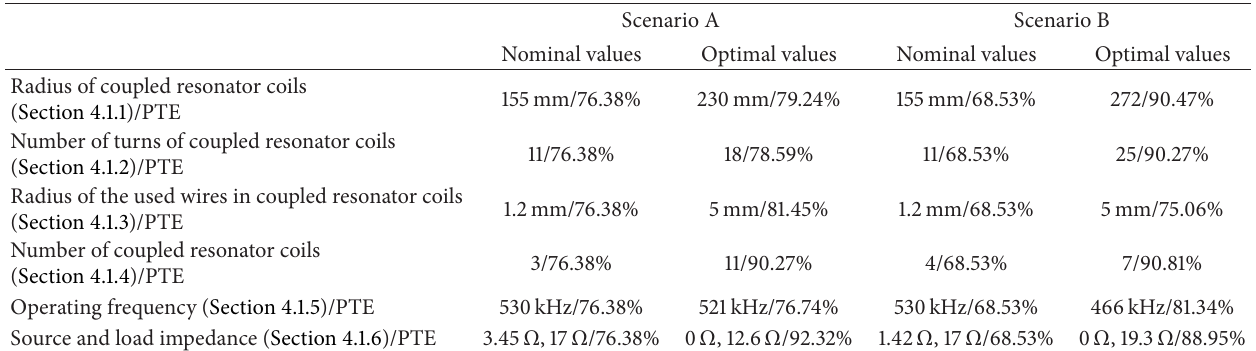
Table 3: Design parameters and the two DCR configuration scenarios: PTE and nominal and optimal parameter